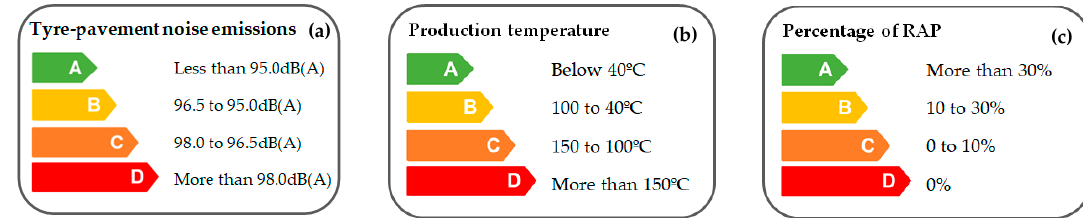
Figure 23. Tire–pavement noise emissions ( a ), production temperature ( b ), and percentage of recycled asphalt pavement (RAP) labels ( c ).